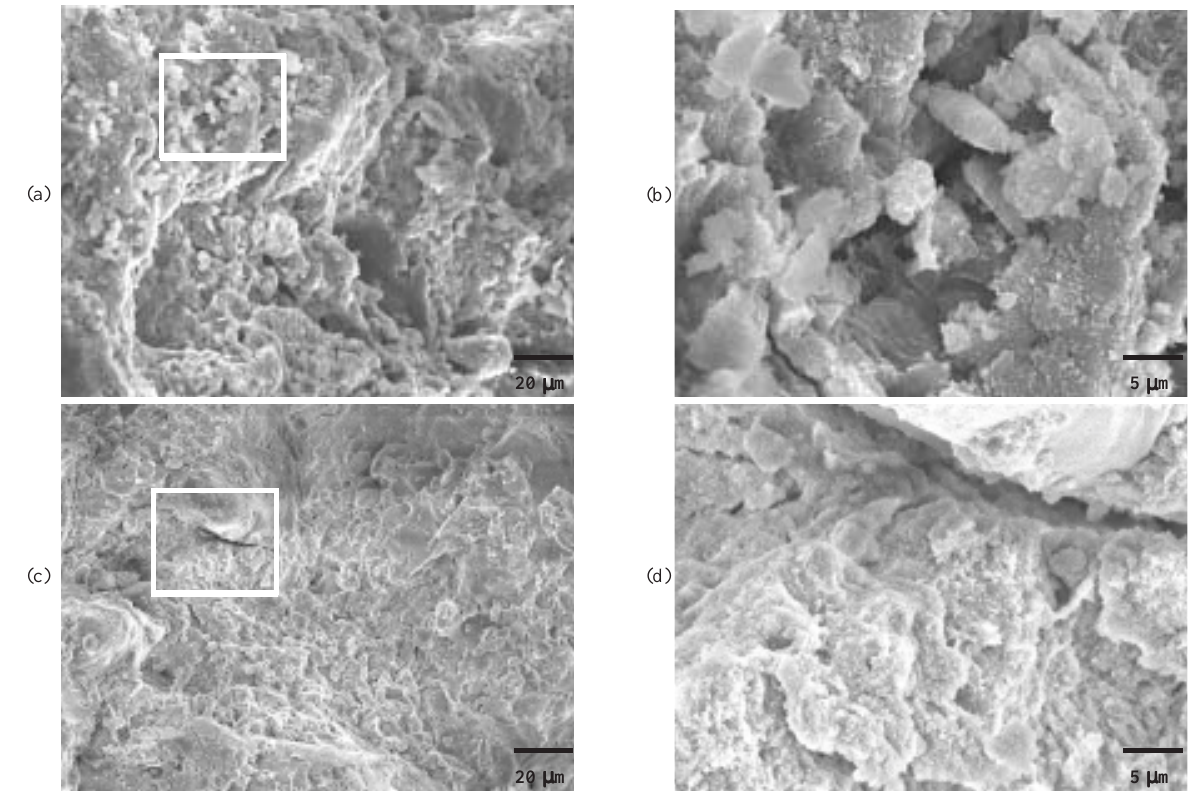
Figura 3. Micrografias obtidas por microscópio eletrônico de varredura (MEV) em amostras de solo na camada de 0,2–0,4 m. (a) solo sob mata nativa mostrando estrutura porosa; (b) ampliação da foto “a” mostrando poros entre partículas primárias e microagregados; (c) solo sob sequeiro mostrando aspecto coeso na matriz do solo; (d) ampliação da foto “c” mostrando superfície adensada com aspecto de orientação de partículas e poros tipo